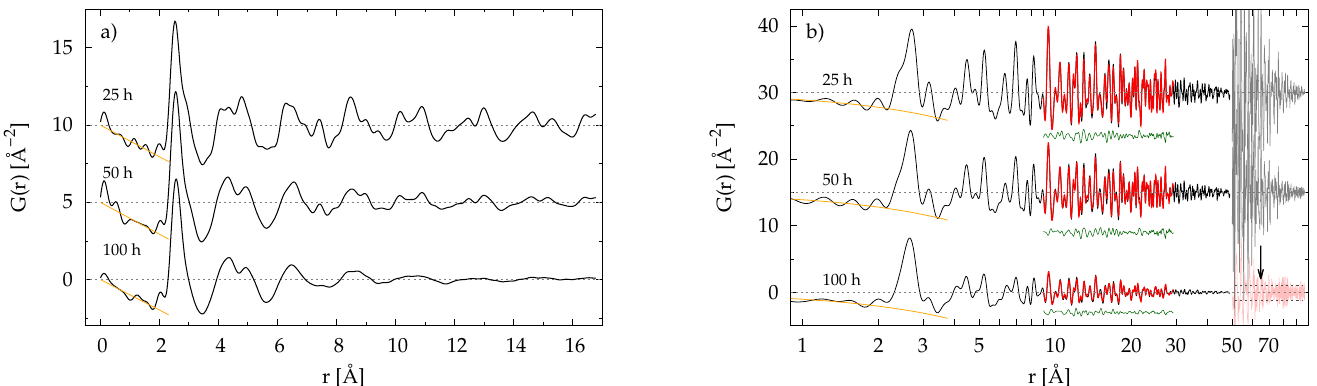
Figure 6. Room-temperature total pair distribution functions G ( r ) for ( a ) CoFeTaB and ( b ) CoFeWB samples after 25, 50 and 100h of mechanical alloying. The mean atomic number density ρ 0 was determined by a linear fit of G ( r ) ’s low r part (where r ≤ 1.8Å) to − 4 π r ρ 0 (depicted by solid orange lines). For better clarity, curves are vertically offset. In case of CoFeWB sample, corresponding G ( r ) s were fitted on r -range (cid:104) 9,29 (cid:105) Å. Fitting and difference curves are depicted by solid red and green lines, respectively. The tails above 50Å are magnified by a factor 50 (for W-25 and W-50) and 100 (for W-100). Small arrow located at r = 65Å indicates a distance at which signal enters a noise level, depicted by two parallel dashed